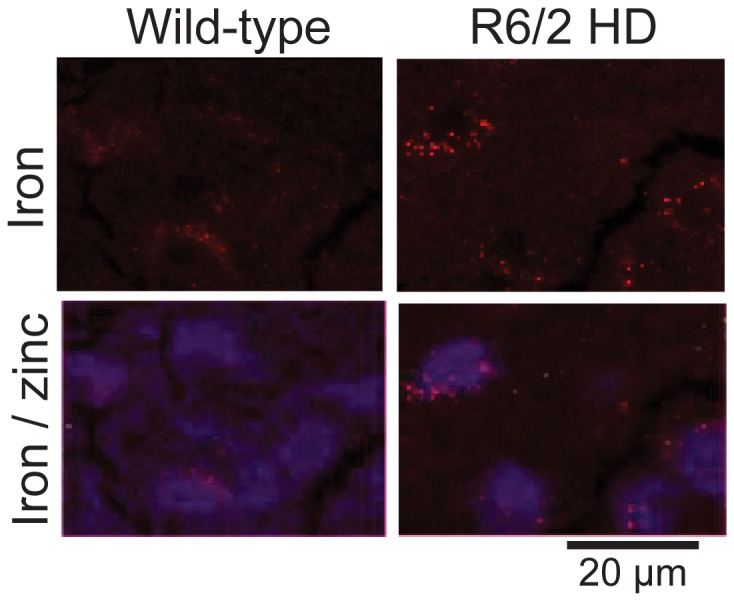
Iron accumulates in R6/2 HD striatal neurons.Striata of 12-week-old R6/2 HD and wild-type litter mate mice were studied by synchrotron x-ray fluorescence (XRF - see methods). XRF identifies neuronal nuclei due to high zinc content (blue) [33]. HD mice demonstrate punctate peri-nuclear (cytoplasmic) accumulations of iron. Shown are representative images. n=2.